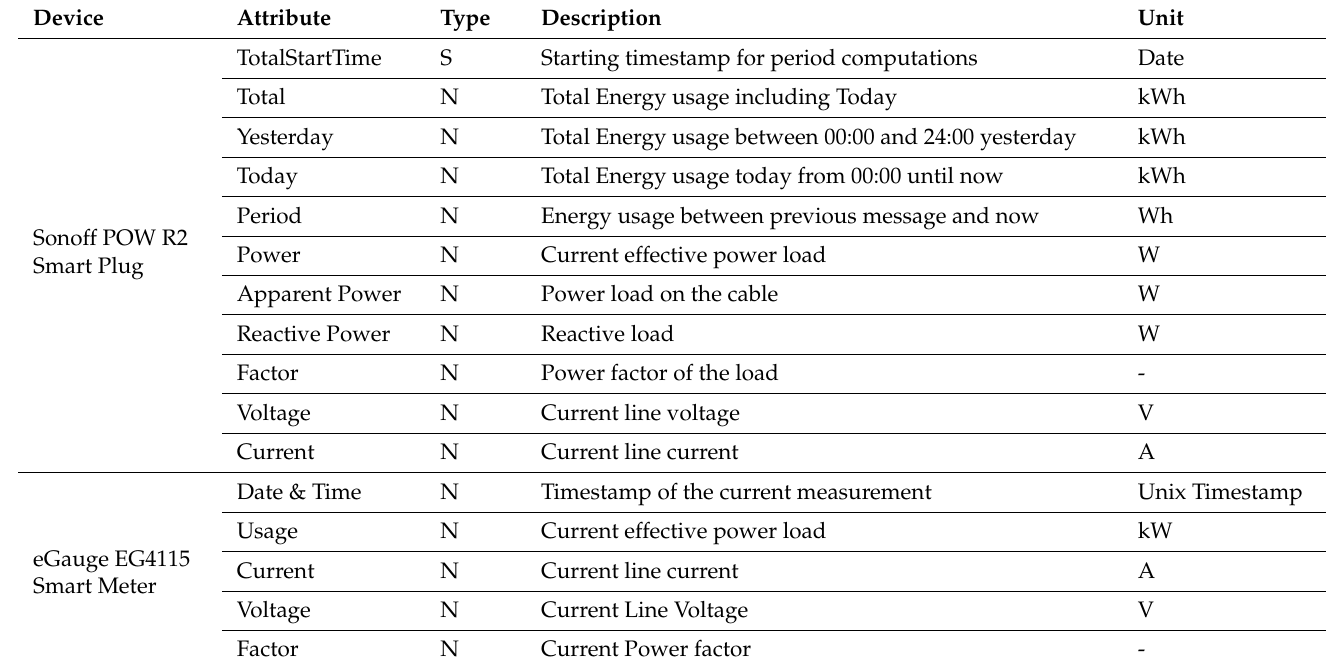
Table 2. The things, smart plug, and smart meter energy data collection attributes on messages.